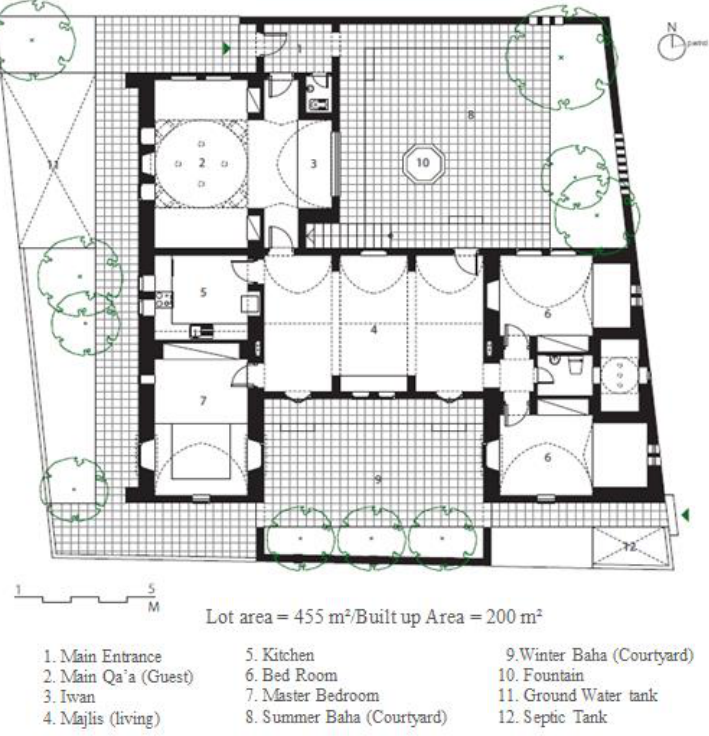
Figure 4. House plan (drawings courtesy of M. Hosam Jiroudy,